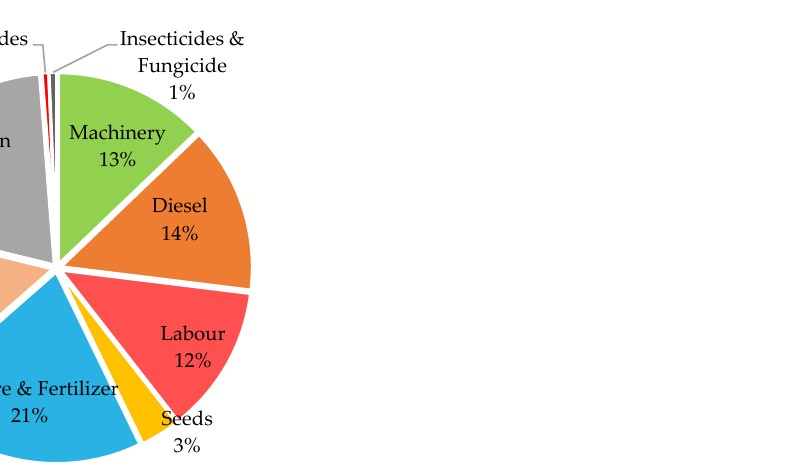
Figure 7. Source-wise equivalent carbon emission (kg CO 2 -e ha −1 ) for fodder maize varieties sown under different nutrient management practices (mean of two years).